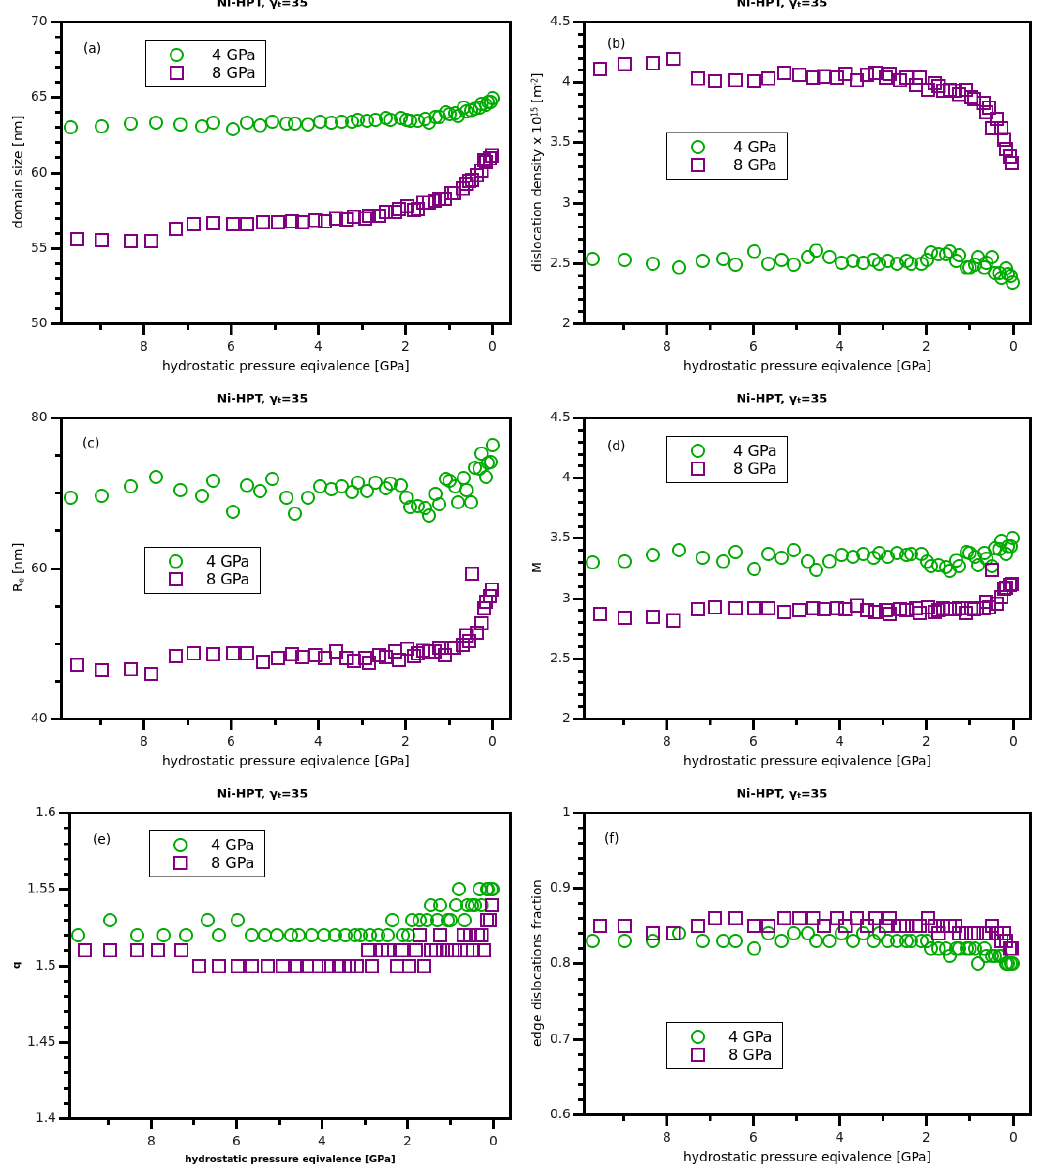
Figure 7. The evolution of the microstructural parameters for nickel after HPT deformation at 4 and 8 GPa as obtained by the CMWP fit: the coherently scattering domain size ( a ); the dislocation density ( b ); the outer cut-off radius of the strain field of dislocations ( c ); the M -parameter as a measure of the mutual strain field screening of dislocations ( d ); the contrast parameter q ( e ); the fraction of edge dislocations as determined from q ( f